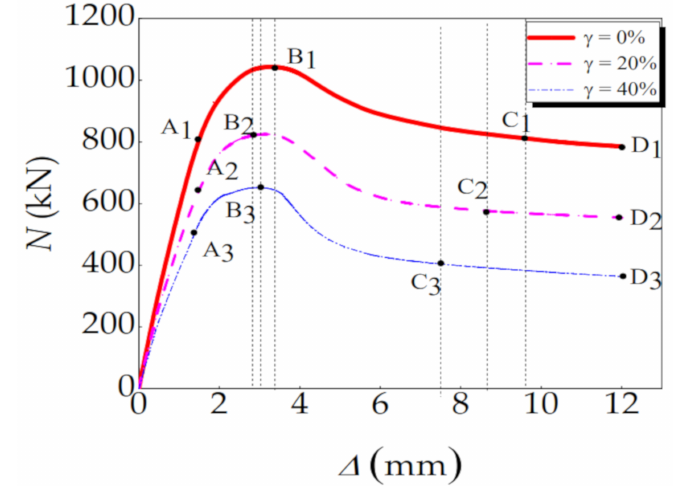
Figure 7. Load-vertical displacement curve of